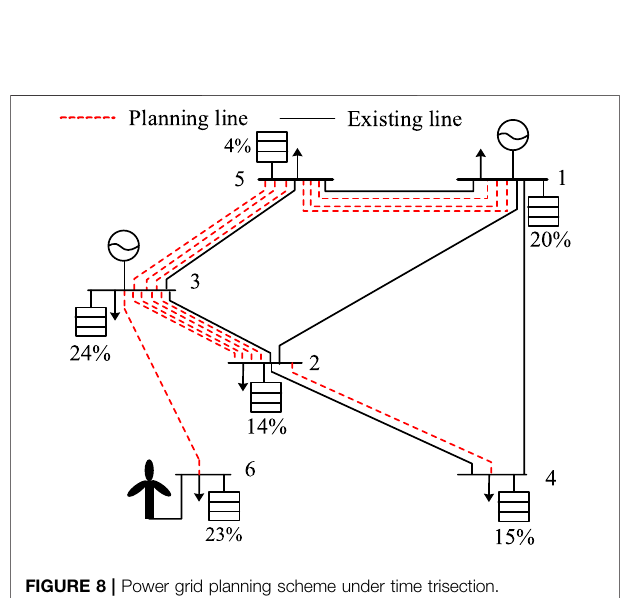
FIGURE 8 | Power grid planning scheme under time trisection.